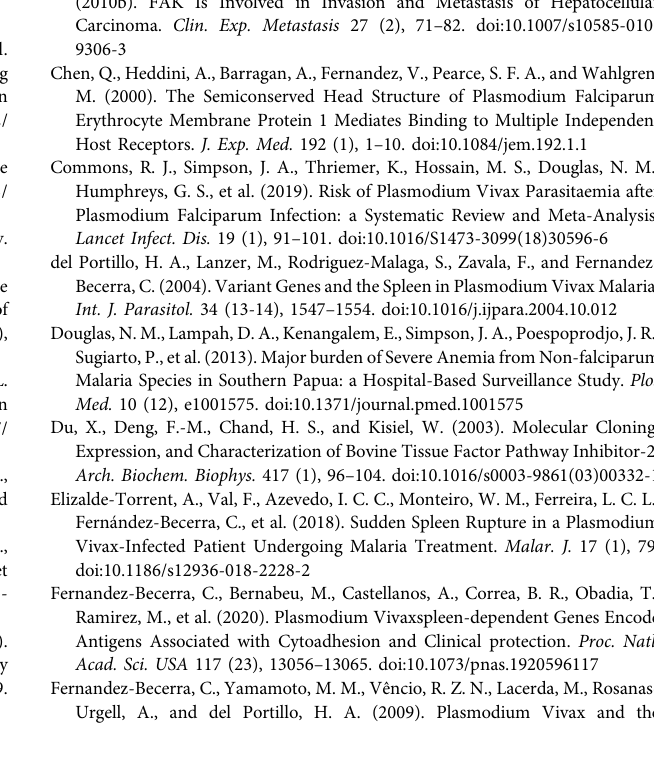
Supplementary Table 1 | Quantity analysis of the genetic changes in gene expression between normal HSF and PvSRA-treated HSF by RNA-seq. Supplementary Table 2 | Detecting of the protein substrates of PvSRA by Human proteome microarray analysis. Supplementary Figure 1 | Determination of the use concentration of PvSRA by protein arrays. (A) Protein arrays probed with anti – 6 × His-tag antibody. (B) Correlation between spot intensities and the serial diluted puri fi ed His-tagged PvSRA protein. Supplementary Figure 2 | Comparison of IgG antibody responses to recombinant proteins PvMSP1-19. Supplementary Figure 3 | The heatmap of genetic changes in gene expression between normal HSF and PvSRA-treated HSF. Supplementary Figure 4| Expression change ofthe differentially expressed genes (DEGs)thatwereinvolvedin (A) extracellularmatrix, (B) focaladhesion,and (C) actin